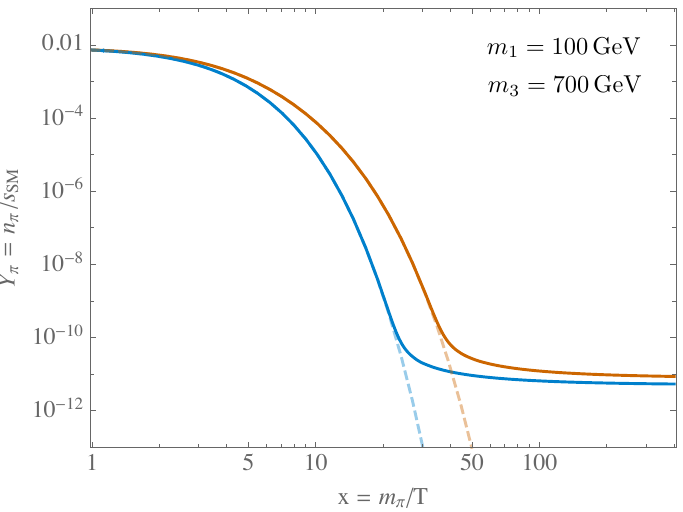
Figure 12 . Thermal evolution of the dark pion abundance obtained by solving numerically the system (C.1) with a = 1 / 2 and N DC = 4 . The numerical solution for ε . 10 − 8 (solid orange line) traces the combination ( Y 2 /Y 2 ) Y 2 (dashed orange line) until the freeze out. For comparison, π,eq γ D ,eq γ D we also show the thermal abundance of dark pions for ε > 10 − 8 (solid blue line), corresponding to the ordinary freeze-out evolution of eq. (5.6), and its thermal equilibrium density Y π,eq (dashed blue line).